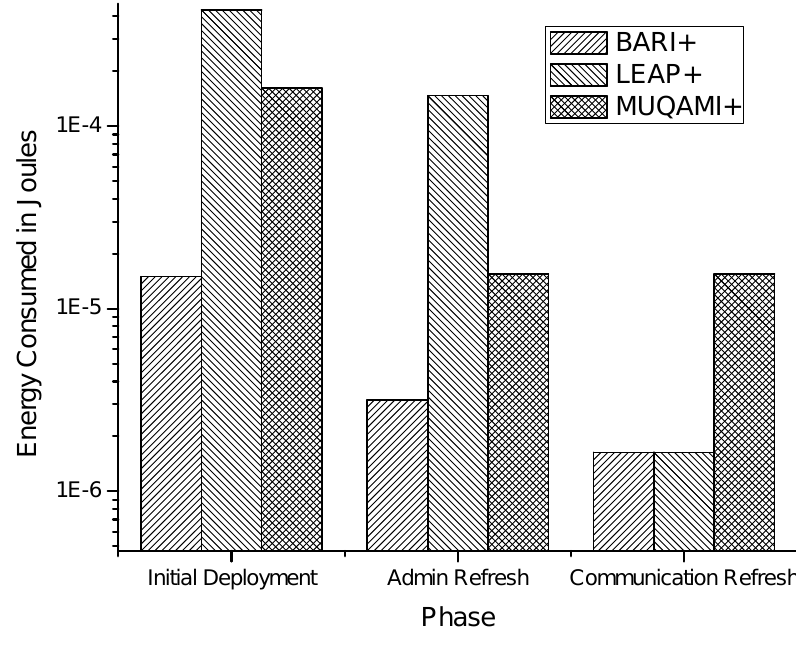
Figure 6. Comparison of average energy consumed by a node (including sensor nodes and the personal server) in different phases of each